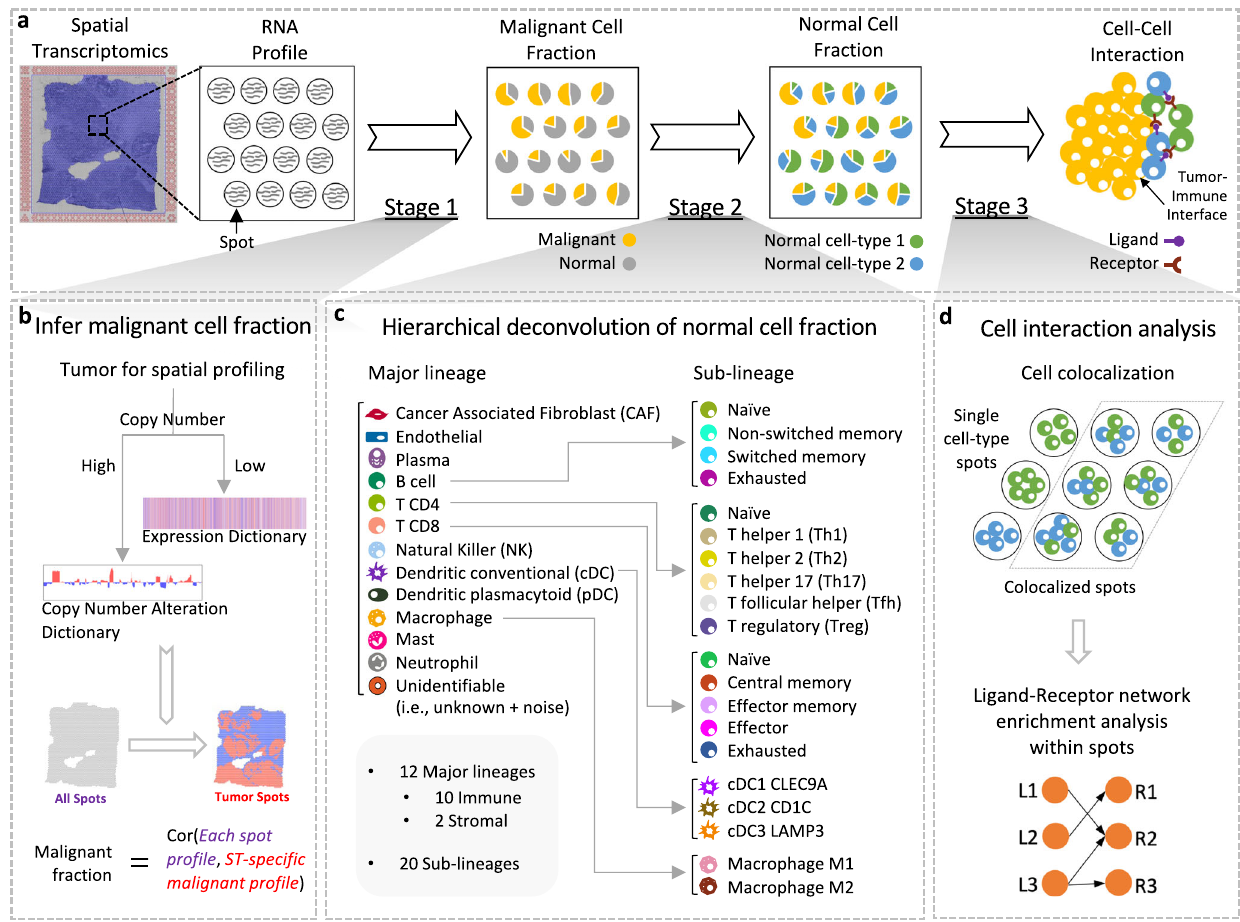
Fig. 1 | Inferring cell fractions and interactions in tumor spatial tran- scriptomics. a Three stages from input spatial transcriptomics (ST) data to cell lineage fractions and intercellular interactions. b Malignant cell fraction inference throughagenepatterndictionary.ForatumorSTdataset,SpaCETusesadictionary of copy number alterations or tumor transcriptome patterns to identify tumor spots and further computes an ST-speci fi c malignant expression pro fi le. Then, SpaCET correlates the ST-speci fi c malignant pro fi le with the expression pro fi le of each spot and normalizes the correlation coef fi cients to 0 – 1 as the malignant fractions of all spots. c Hierarchical deconvolution of nonmalignant cell